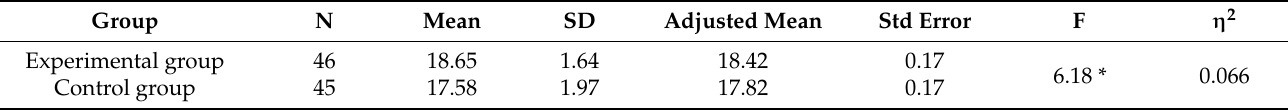
Table 3. The ANCOVA results for awareness of